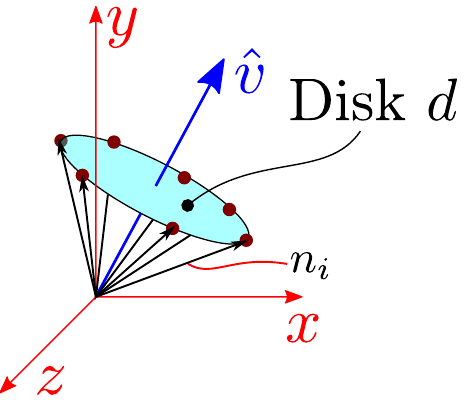
Figure 10. Cone fitting. Dual cone formed with Origin as apex. Unitary vectors normal to S are generatrices for the dual cone. Origin-located tails of n i vectors normal to triangles t i at Origin. Normal vector tips contained in a plane form a flat disk d . Minimal dispersion direction (principal component analysis) of disk d is the direction of cone axis ˆ v